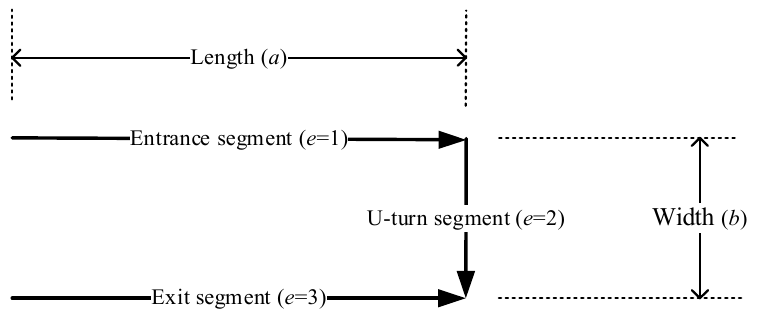
Figure 2. L ength, width and three segments in a U-shaped conveyor assembly line. Figure 2. Length, width and three segments in a U-shaped conveyor assembly